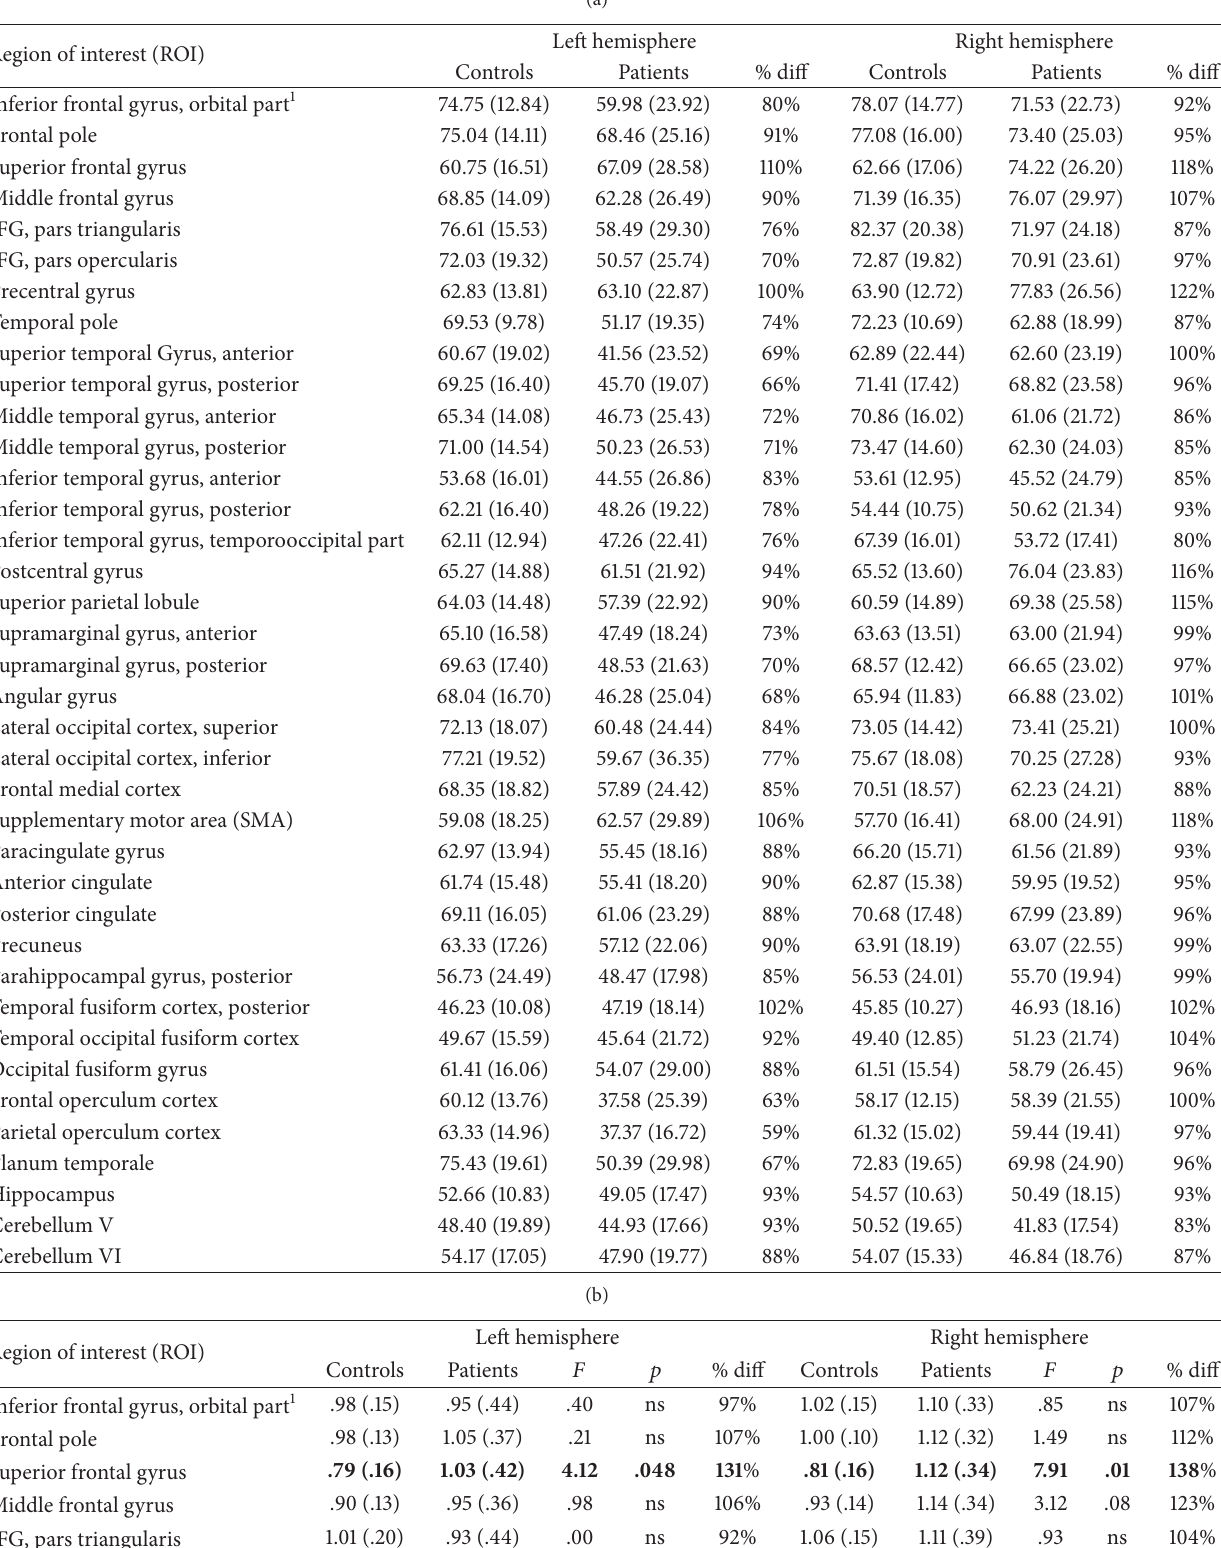
Table 4: (a) Mean raw perfusion values (and standard deviation) for each region of interest (ROI) for patients and healthy controls in the left and right hemisphere. (b) Mean right-occipital-normalized perfusion values (and standard deviation) for each region of interest (ROI) for patients and healthy controls in the left and right